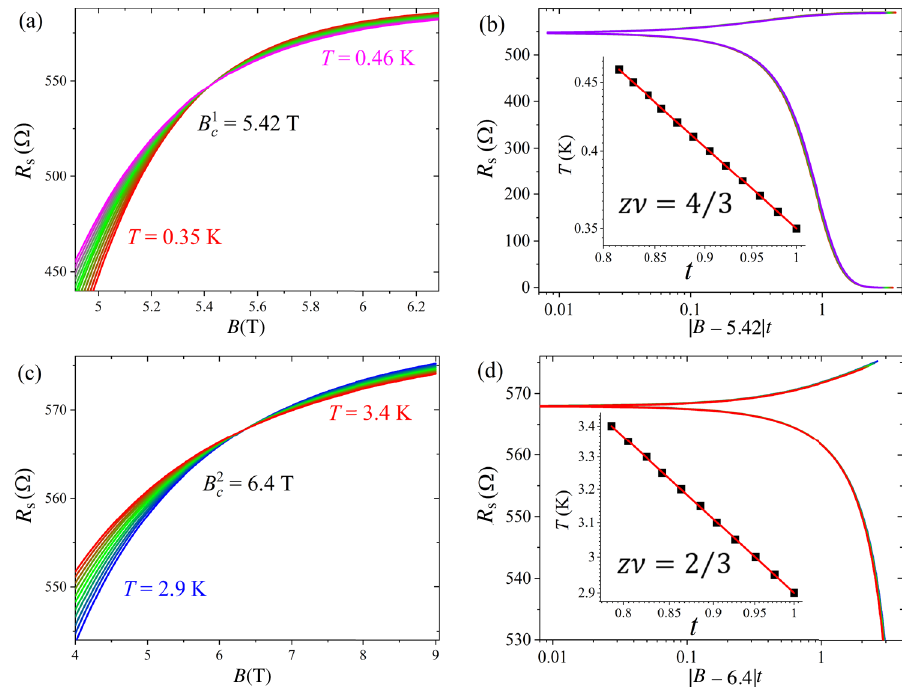
Fig. 4 Scaling analysis on the superconductor-to-Bose insulator quantum phase transitions of the 1000 µ m-wide bridge. a Sheet resistance R s as a function of magnetic fi eld at temperatures from 0.35 to 0.46 K, showing a distinct crossing point at the Bose insulator quantum critical fi eld B 1 (cid:1) (cid:1) (cid:1) (cid:1) t . Inset: temperature dependence of the scaling parameter t , with a product of the correlation length and analysis plot of R as a function of B (cid:3) B 1 s c dynamical exponents z ν ¼ 4 = 3. c R s B ð Þ curves at temperatures from 2.9 to 3.4 K, manifesting the pair-breaking critical fi eld B 2 . Inset: temperature dependence of the scaling parameter t , with z ν = analysis plot within the critical regime a t B 2 c